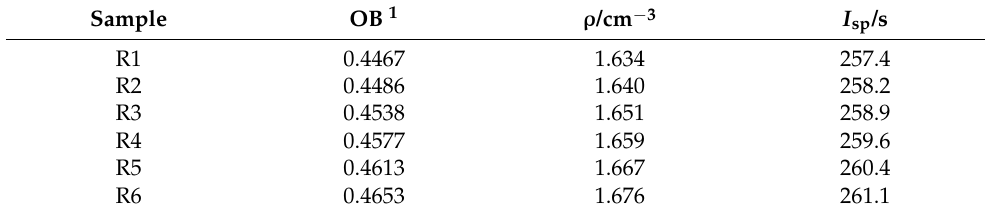
Table 2. The theoretical specific impulse of prepared